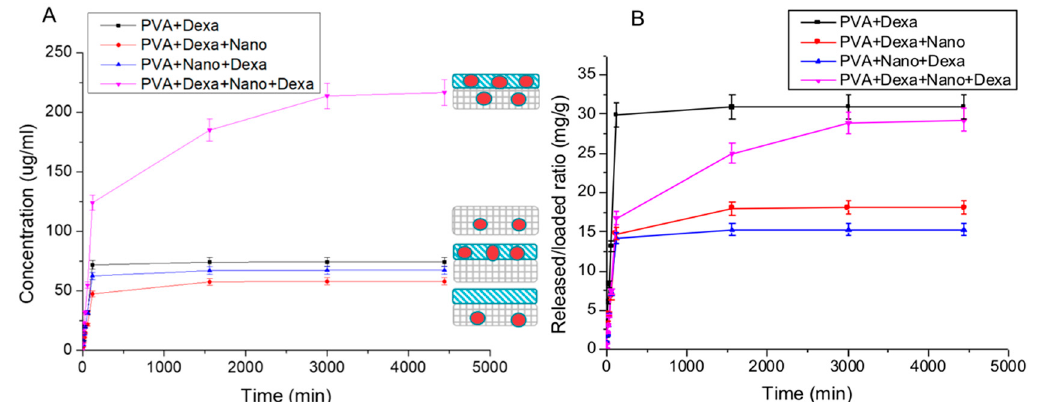
Figure 6. ( A ) Concentration of Dexa released from different samples versus time; ( B ) amount of Dexa released with respect to the initial content of the loaded drug for all samples examined.